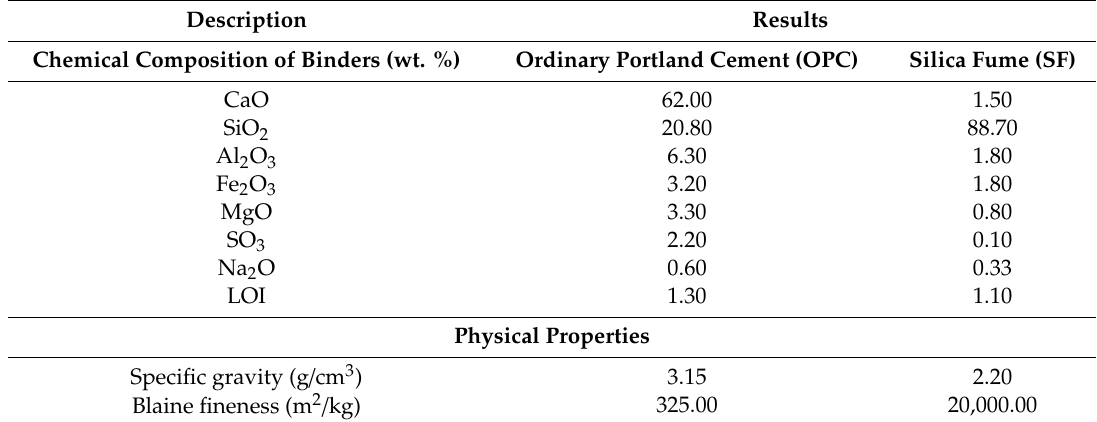
Table 1. Chemical composition and physical properties of used binders.